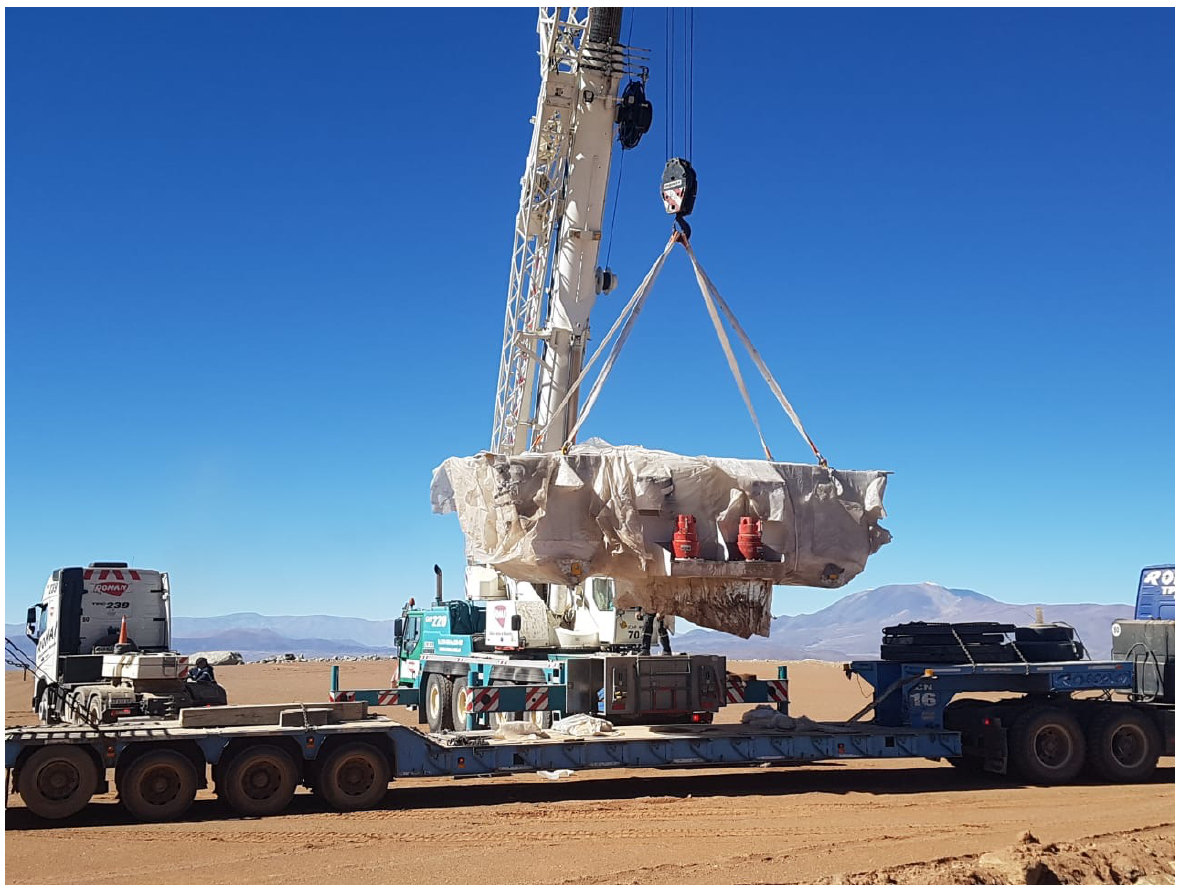
Figure 2. The Yoke Traverse, a piece of the antenna which had to be reconstructed by VERTEX due to an accident, arriving at the site of the